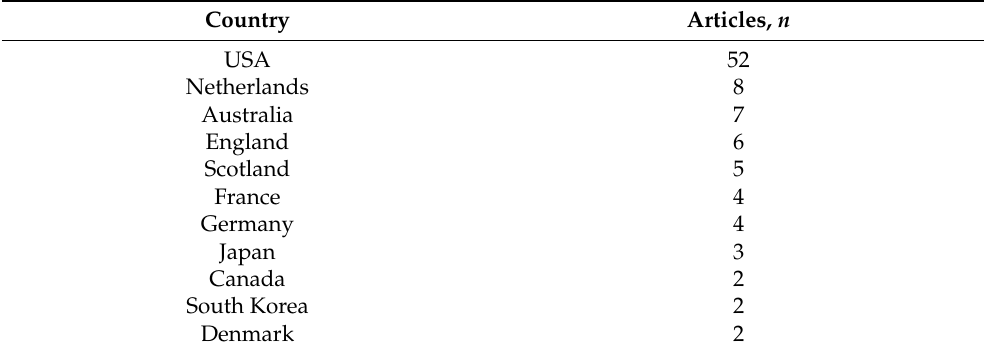
Table 3. Countries of origin of the 100 most-cited articles on post-intensive care syndrome. Country Articles, n